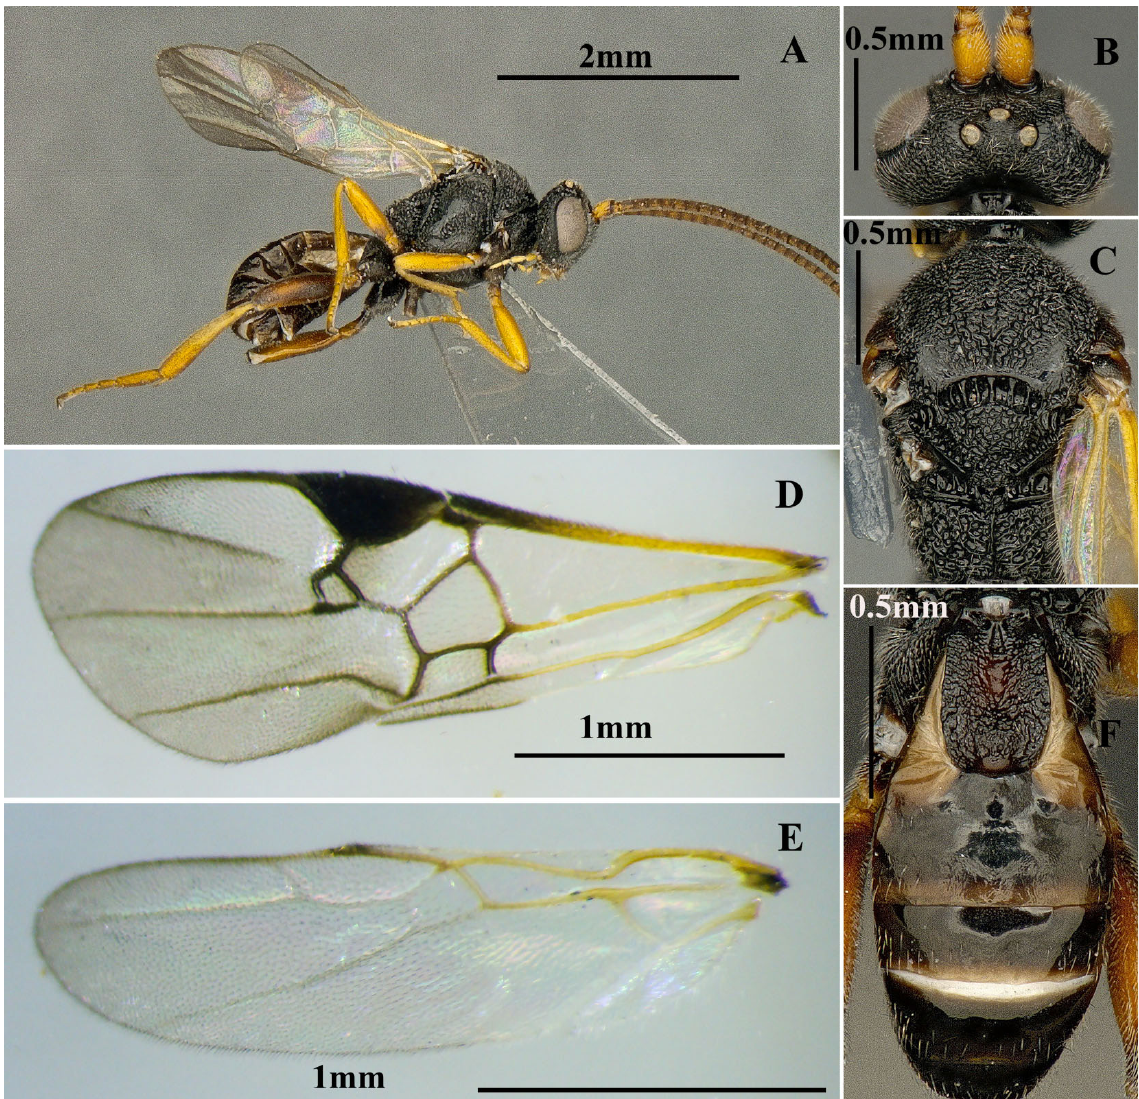
Fig. 4. Microplitis docilis Nixon, 1970, ♀, TMUC-HBMMP0013. A . Habitus, lateral view B . Head, dorsal view. C . Mesosoma, dorsal view. D . Fore wing. E . Hind wing. F . Metasoma, dorsal